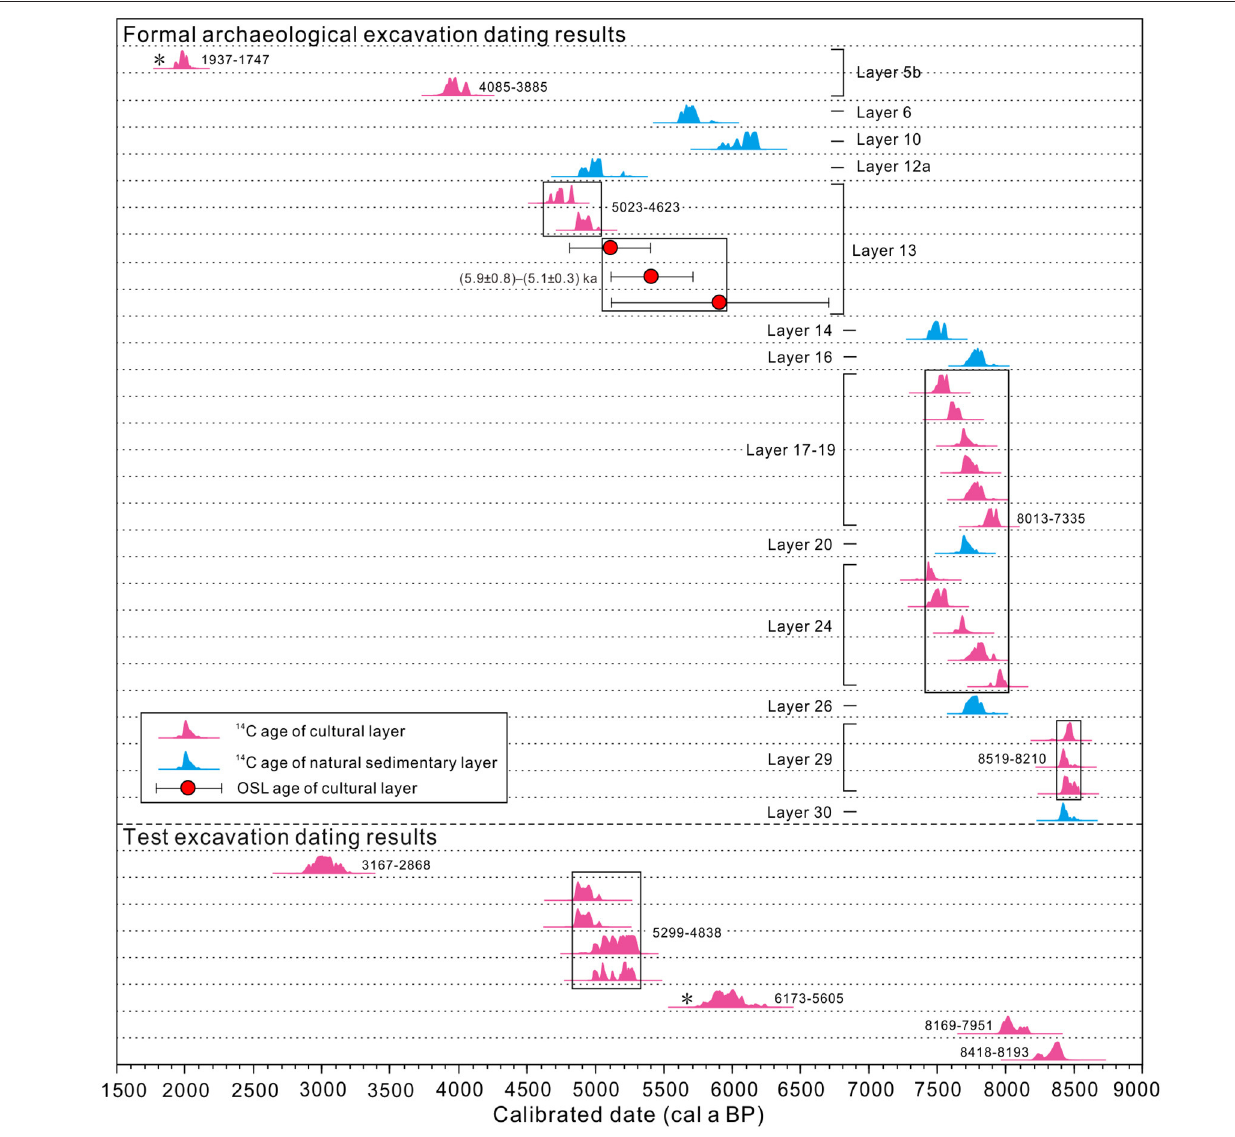
411–342 cm, except for peaks at 399 cm and 363 cm,